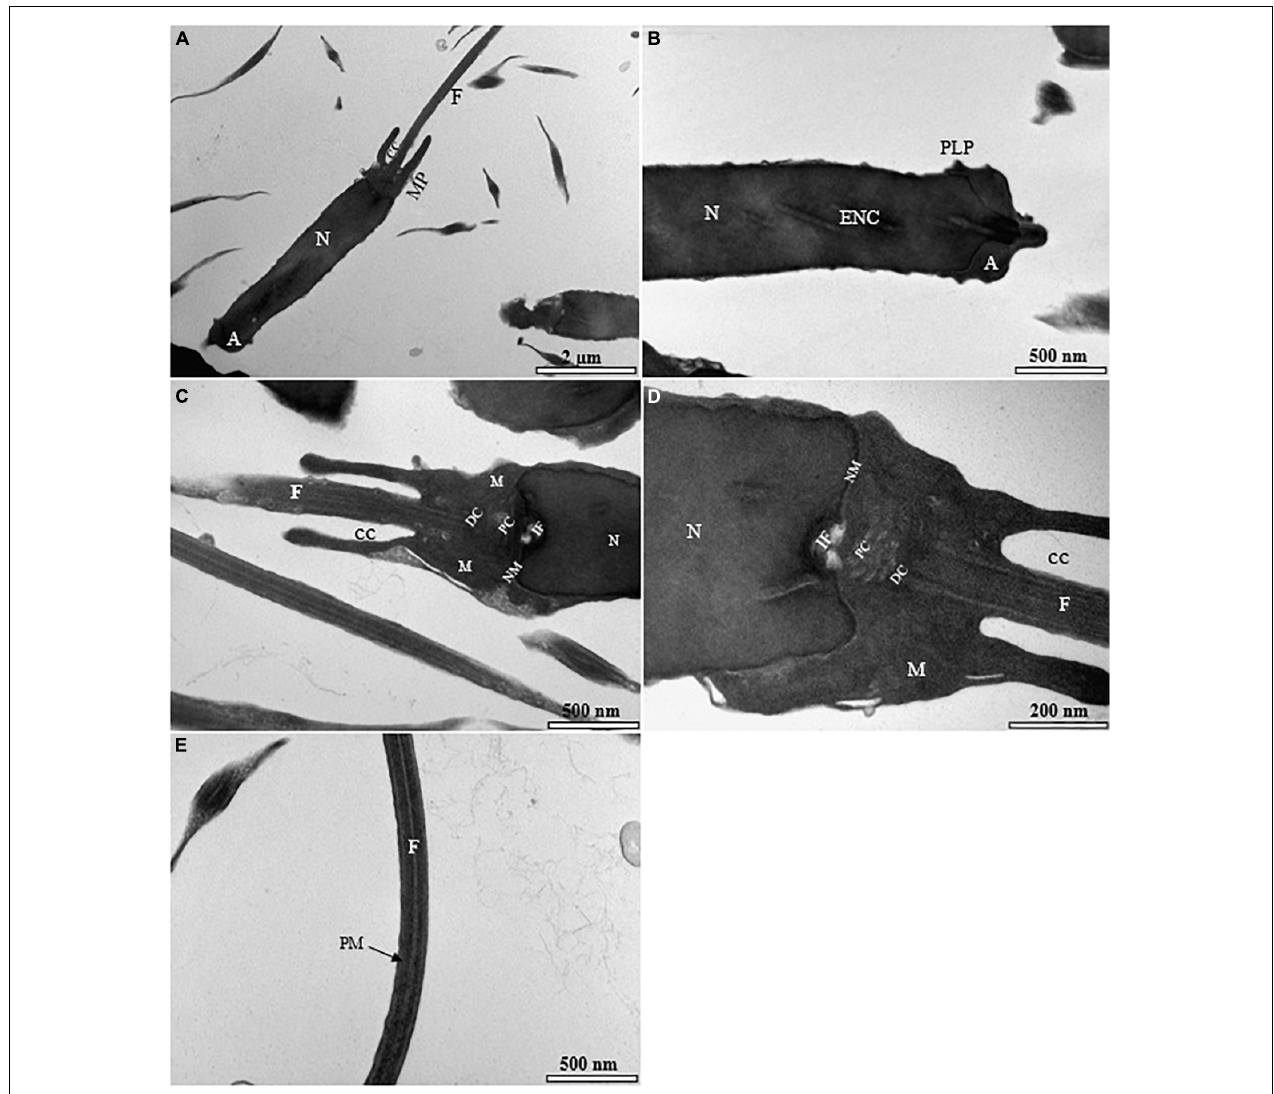
FIGURE 7 | Transmission electron micrographs of the fresh spermatozoon in sterlet. (A) Longitudinal sagittal section of the spermatozoon showing different parts of the cell; (B) higher magnification longitudinal section of the truncate of spermatozoon exhibiting acrosome (A), endonuclear canals (ENC), nucleus (N), and posterolateral projections (PLP); (C) ultrastructure of the midpiece showing nuclear membrane (NM), flagellum (F) separated by cytoplasmic channel (CC), mitochondrion (M), distal centriole (DC), proximal centriole (PC), and implantation fossa (IF); (D) higher magnification of spermatozoon midpiece region displaying various normal and unchanged sections of the spermatozoon; (E) higher magnification of spermatozoon flagellum showing cytoplasmic canal without abnormality in the plasma membrane (PM).